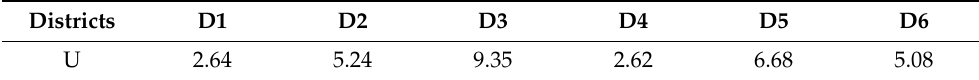
Figure 17. Hangzhou Qianjiang New City skyline’s building undulation. Table 6. Building undulation data for each districts.